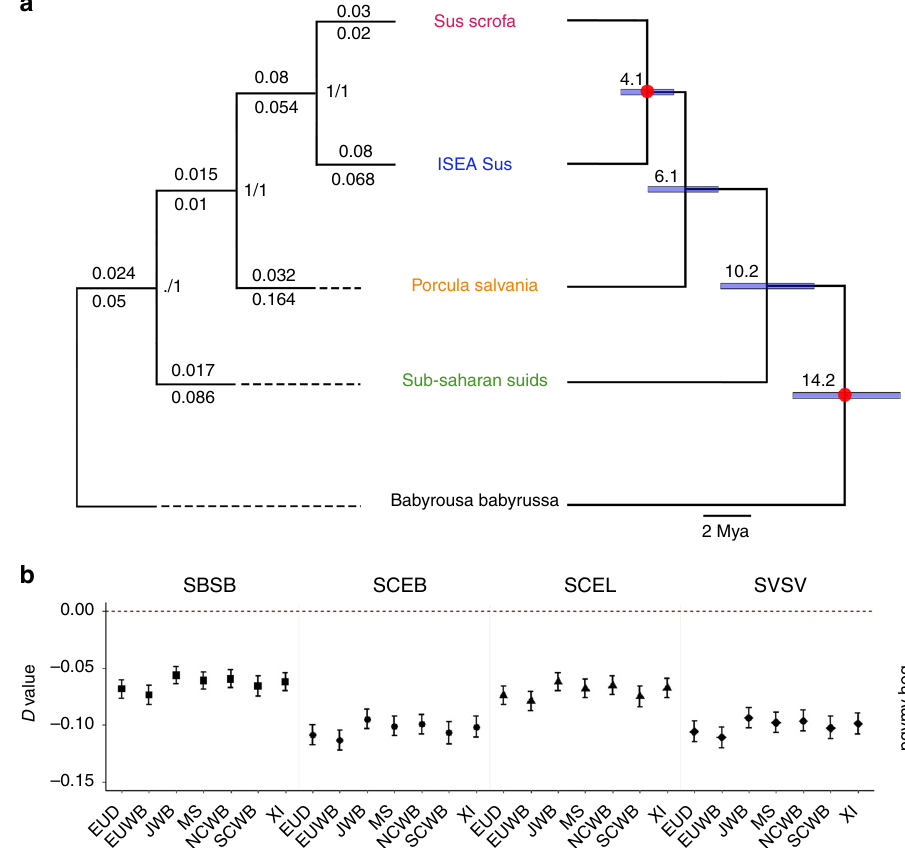
Fig. 2 Phylogenetic relationships and divergence of the Suidae species used in the current study and admixture event between pygmy hog and Sus scrofa . a The tree on the left is the ML tree of the Suidae family based on consensus and concatenation methods. Branch length of the consensus analysis above branches, concatenation below branches. Node labels show bootstrap values of the concatenation analysis and concordance factors of the consensus analysis, respectively. The tree on the right is the time tree of divergence. Node labels show age in million years. Blue bars indicate 95% con fi dence interval and red dots show the calibration points (See Supplementary material Figs. 1 – 3 for full trees). b A diagram depicting the excess derived allele sharing when comparing sister taxa and outgroups. Each column contains the fraction of excess allele sharing by a taxon (up/down) with the pygmy hog/outgroup compared with its sister taxon (up/down). We computed D-statistics of the form D (X, Y, Pygmy hog, warthog). Error bars correspond to three standard errors. (SBSB = Sus barbatus , SCEB = Sus cebrifons , SCEL = Sus celebensis , SVSV = Sus verrucosus , EUD = European domesticated pig, EUWB = European wild boar, JWB = Japanese wild boar, MS = Meishan, NCWB = Northern China wild boar, SCWB = Southern China wild boar, XI =